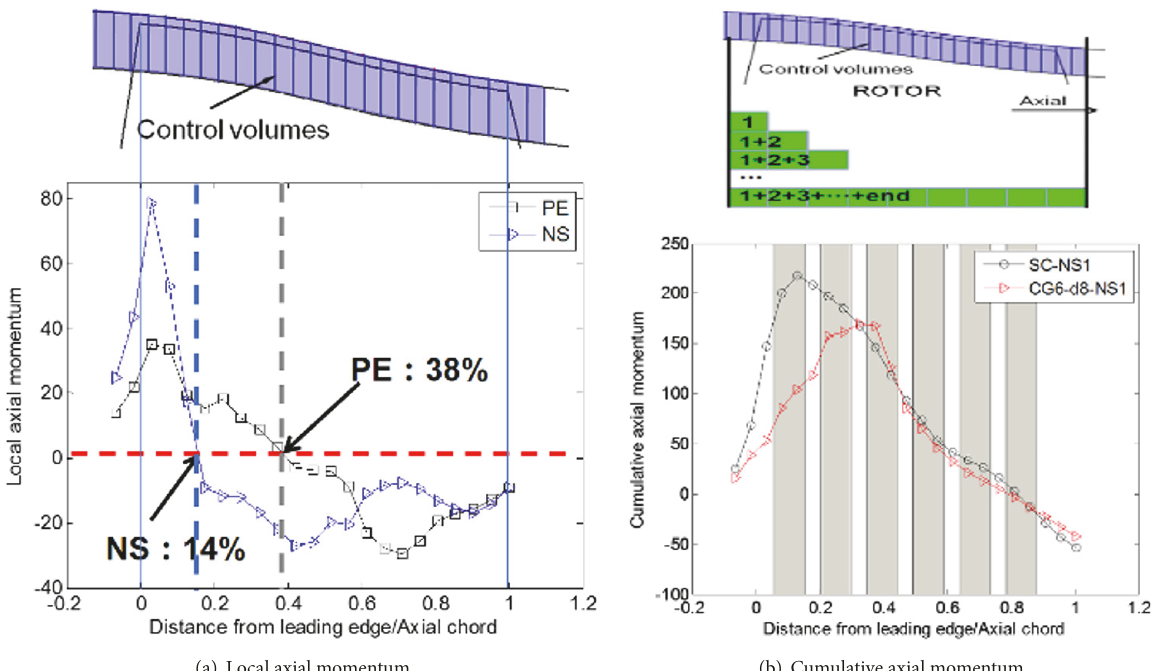
Figure 14: The net axial momentum distributions ([16]). Figure reproduced from NAN et al.